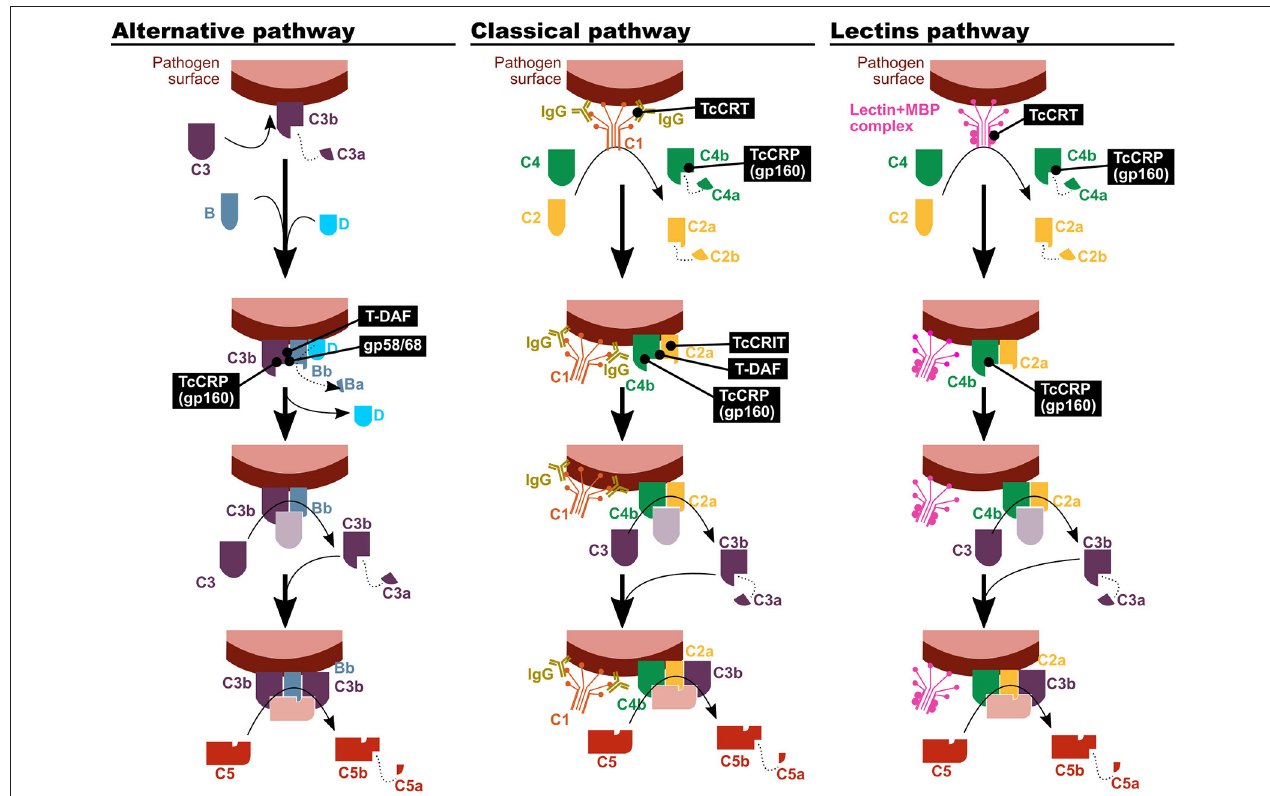
FIGURE 1 | T. cruzi has mechanisms to inhibit the complement system. The parasite proteins involved in the modulation of the three complement activation pathways are indicated in black boxes. TcCRT, T. cruzi calreticulin; T-DAF, trypomastigote decay acceleration factor; TcCRP, T. cruzi complement regulatory protein; TcCRIT, T. cruzi complement C2 receptor inhibitor